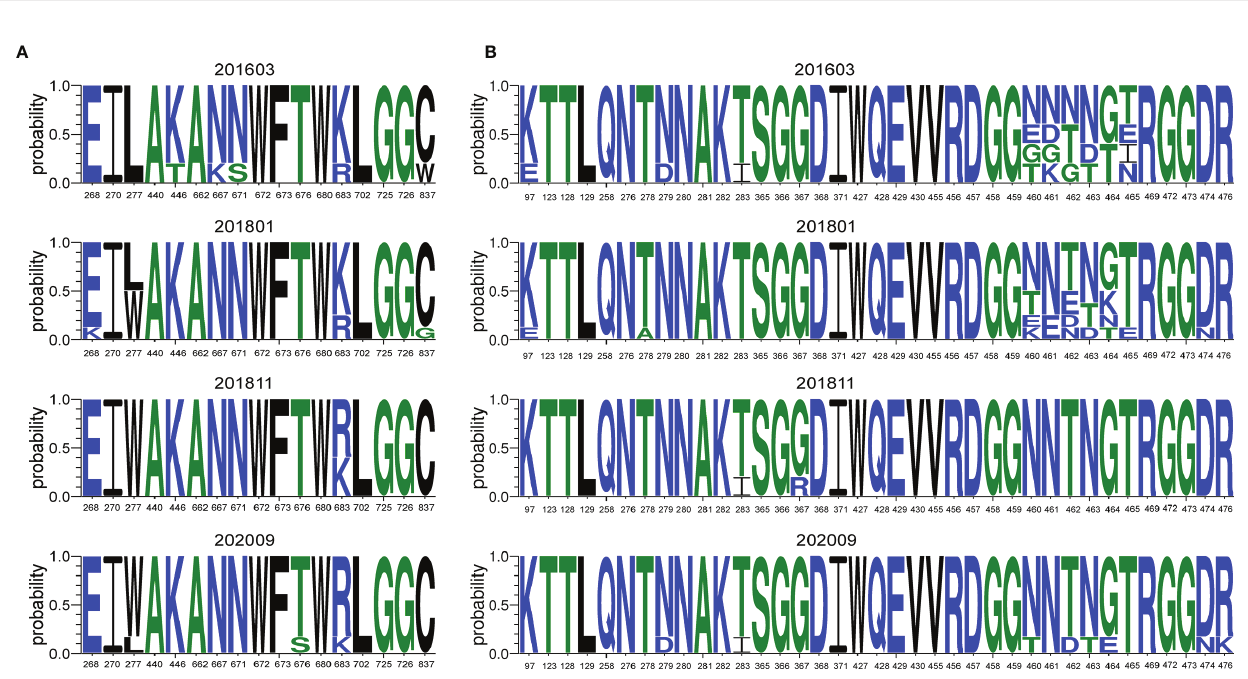
FIGURE 5 | Sequence LOGOs of AA signatures of different bNAbs. The signature sites related with main epitopes or mutation sites associated with neutralization resistance were highlighted. Letter height represents AA frequencies. (A) Sequence LOGOs of AA signatures of key determinants associated with sensitivity to 10E8, 2016 to 2020. (B) Sequence LOGOs of AA signatures of key determinants associated with sensitivity to VRC01, 2016 to 2020.